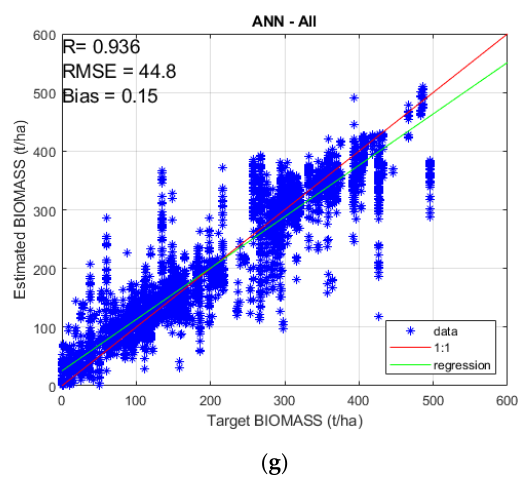
Figure 5. ANN predicted vs. target biomass for ( a ) AfriSAR DLR, ( b ) AfriSAR Onera, ( c ) BioSAR 1, ( d ) BioSAR 2, ( e ) BioSAR 3, ( f ) TropiSAR, and ( g ) all (general algorithm).